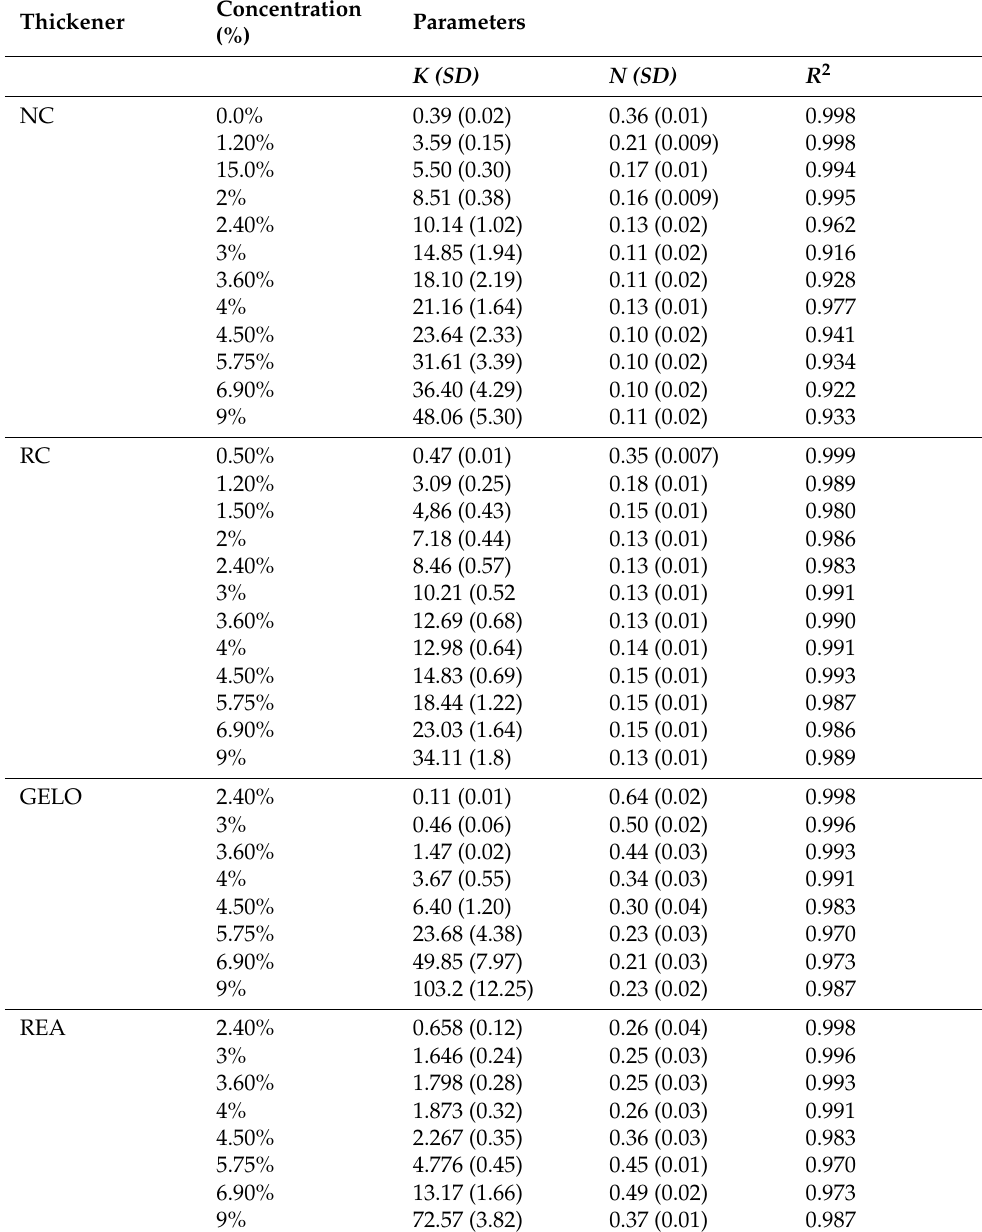
Table 3. Corresponding parameters of the fit to the Ostwald–de Waele model.